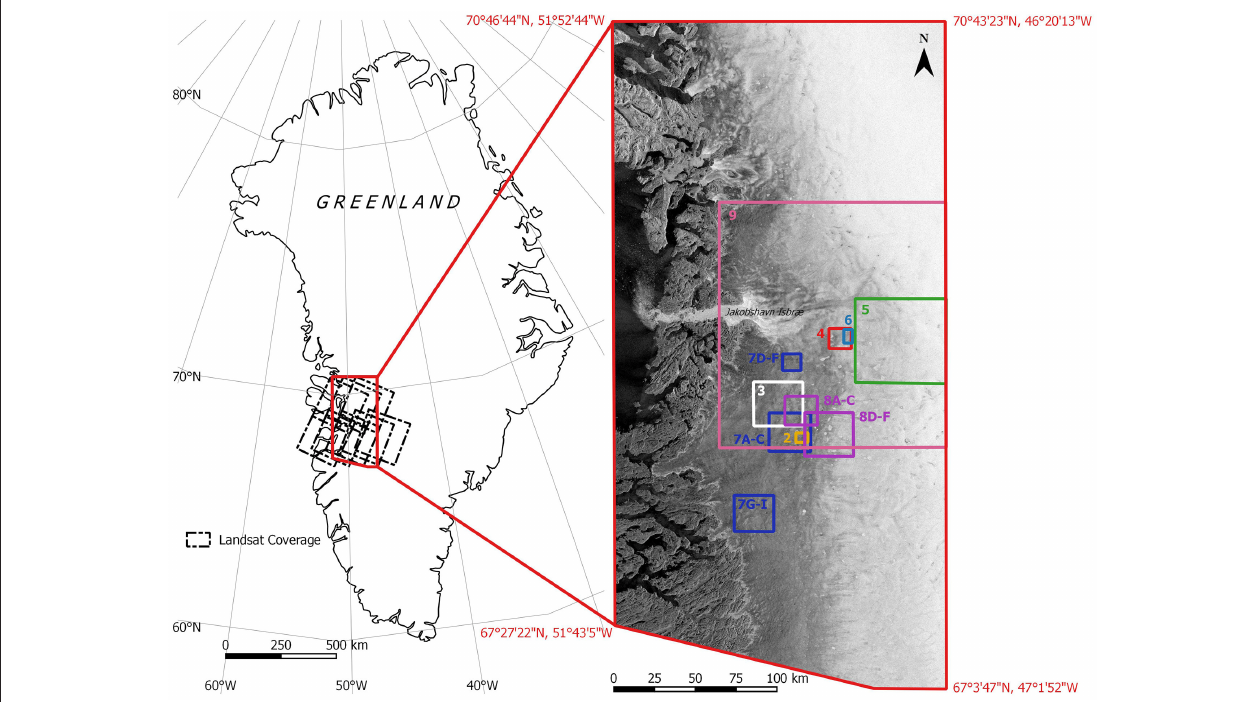
FIGURE 1 | Location of the study region within Greenland, showing the coverage of the Landsat scenes used to define the boundary of the study region. The inset shows the areas used on subsequent figures that do not cover the full study region, mapped onto a Sentinel-1 image (HH polarization) from day 287 (2015).